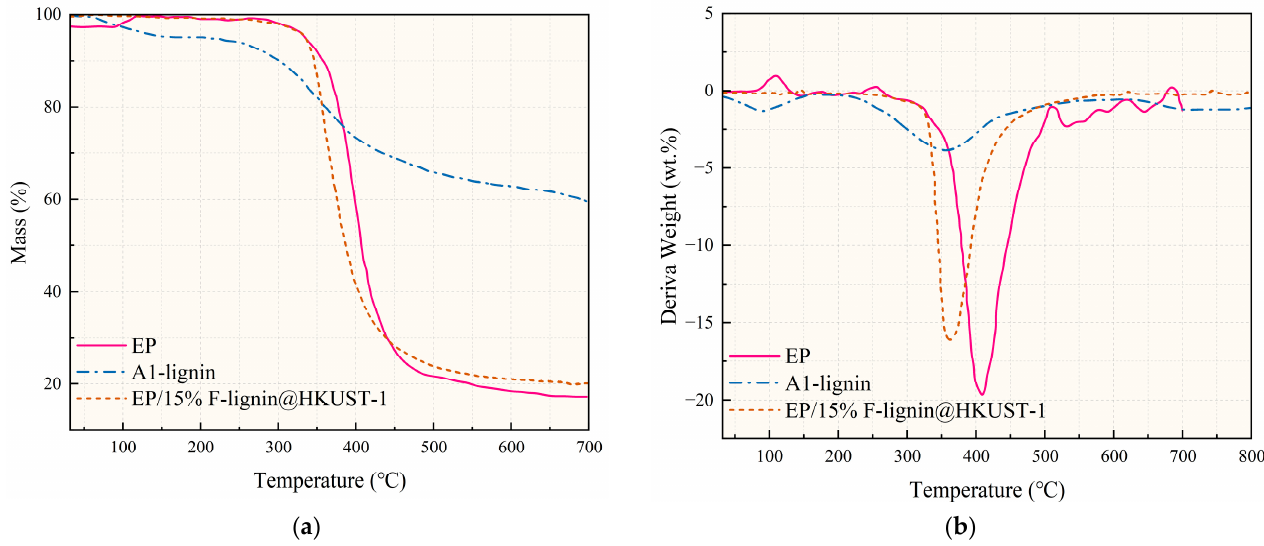
Figure 1. TG ( a ) and DTG ( b ) curves of pure EP and EP composites under N 2 atmosphere. Table 1. TG data of EP, Al-lignin and EP composites under N 2 atmosphere.